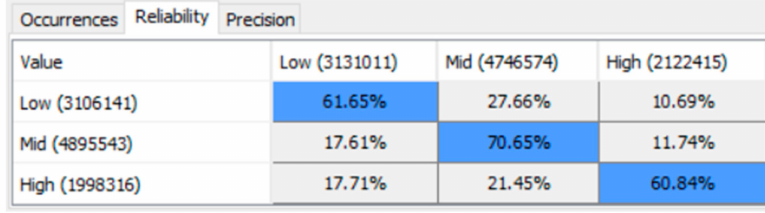
Figure 24. Reliability confusion matrix after performing target evaluation cross-validation by bootstrapping the data in each node 100,000 times.